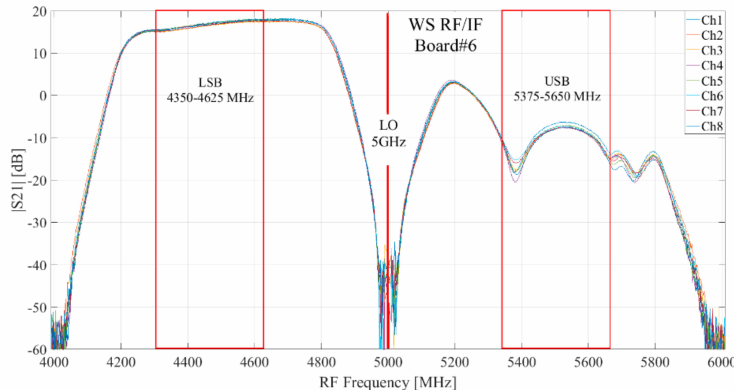
Figure 18. VNA measured transmissions of the eight channels of one of the WS RF / IF boards by selecting filter BPF-A and LO frequency 5 GHz.